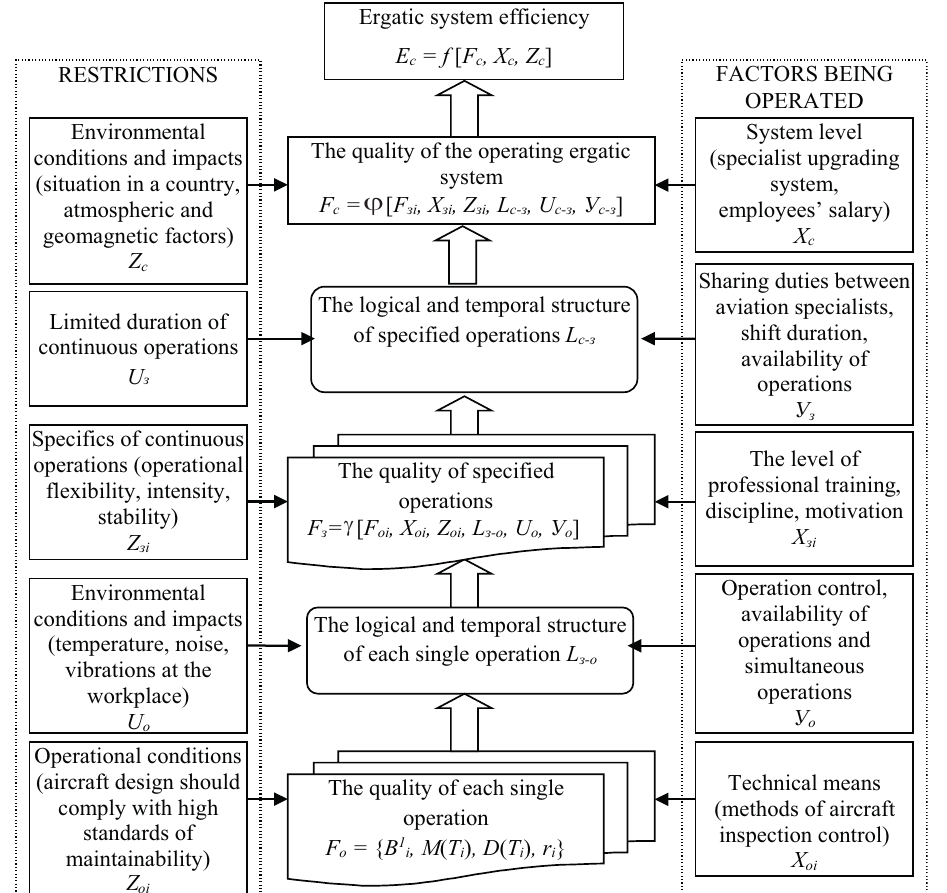
Fig. 1. The diagram of efficiency development of maintenance processes, factors being operated and the restrictions of aircraft